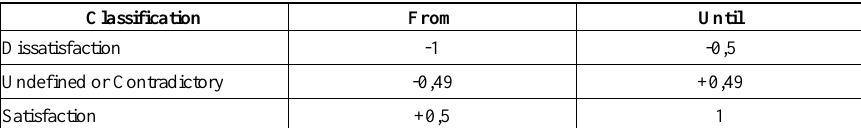
Table 1. Group satisfaction index measurement